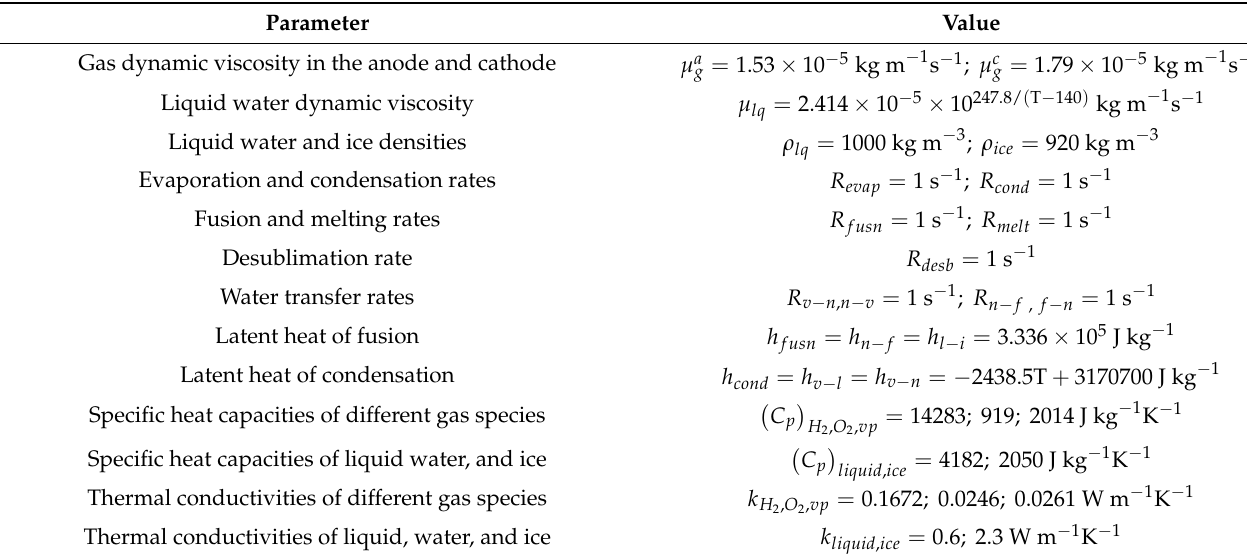
Table 7. Mass transfer parameters